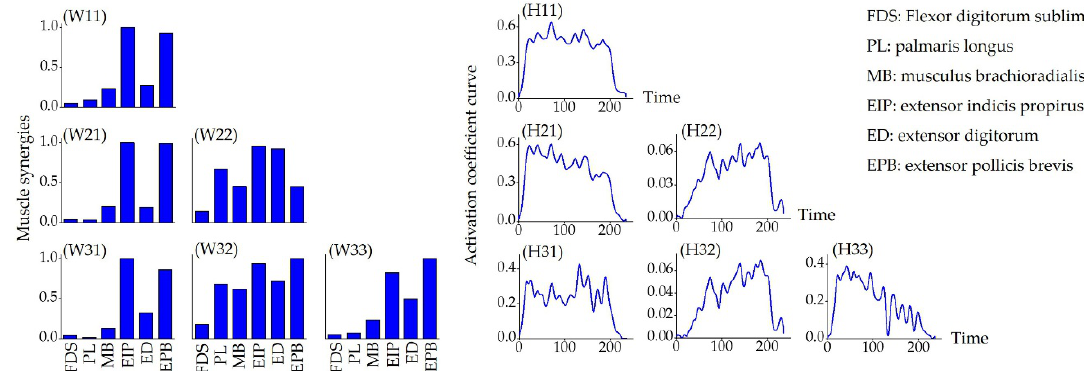
Figure 4. The muscle synergy patterns (left) and the activation coefficient curves (right) for one gesture (gesture E) as the number of synergies increased (s=1 (first row), 2 (second row), 3 (third row)). The channel-muscle configurations were illustrated in Figure 1 as (1) FDS, (2) PL, (3) MB, (4) EIP, (5) ED, and (6) EPB. The NMF algorithm was used to extracted W and H matrix according to equation (3), where W ij was the j th muscle synergy matrix when number of synergies equal to i and H ij was the corresponding coefficient matrix representing contribution of the specific muscle synergy as well ( I = s = 1,2,…,6, and j = 1,2,…, i ).